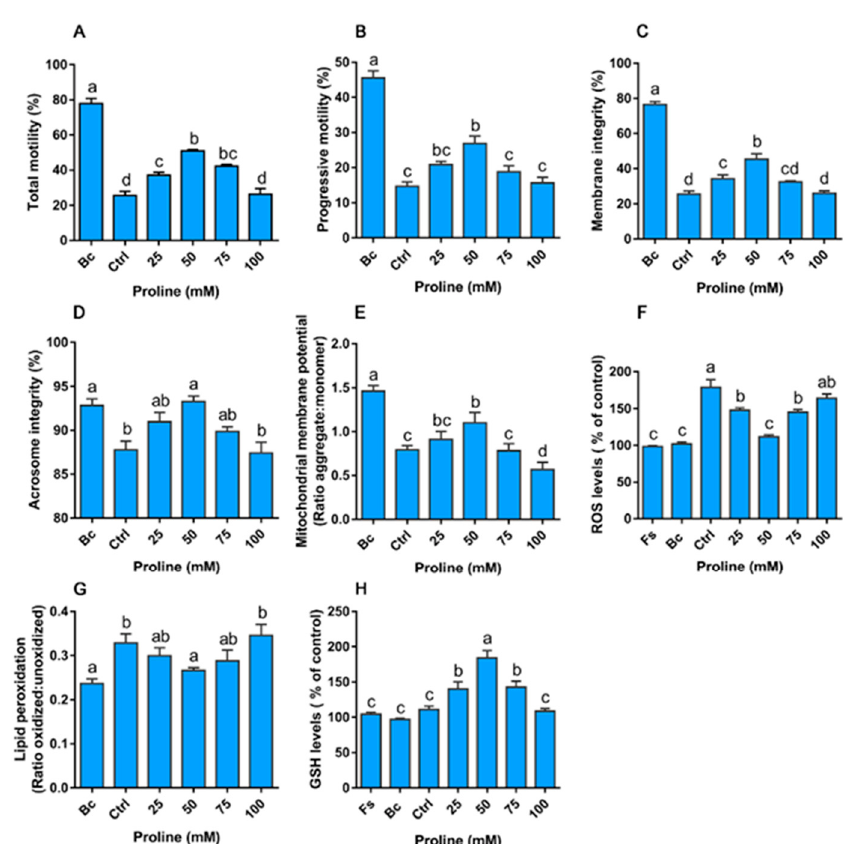
Figure 4. Effect of proline on the function ( A , B ), integrity ( C – E ), and redox environment ( F – H ) of boar sperm during rapid cooling. Samples were supplemented with different concentrations of proline before rapid cooling (from 30 to 5 °C) while samples in the control group were incubated at 30 °C all the time. After that, boar semen was sampled for the subsequent detection. ( A ) Total motility. ( B ) Progressive motility. ( C ) Membrane integrity. ( D ) Mitochondrial membrane potential, results are expressed as the ratio of JC-1 aggregate: monomer. ( E ) Acrosome integrity. ( F ) ROS levels. ( G ) Lipid peroxidation levels, results are expressed as the ratio of oxidized forms: unoxidized forms. ( H ) Glutathione levels. Values are shown as mean ± SEM of three independent experiments. Columns with nonidentical superscripts are significantly ( p < 0.05) different from each other in statistics. Ctrl, control; Bc, before cooling; Fs, fresh semen.